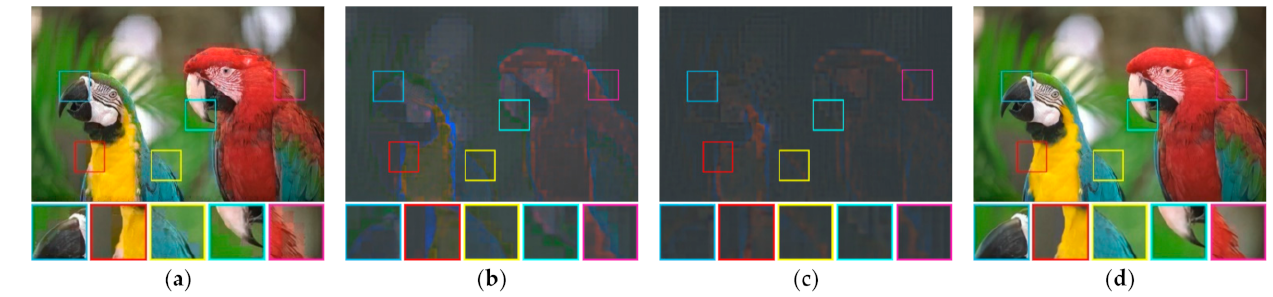
= = = F full , ( b ) F half , ( c ) F quart , and